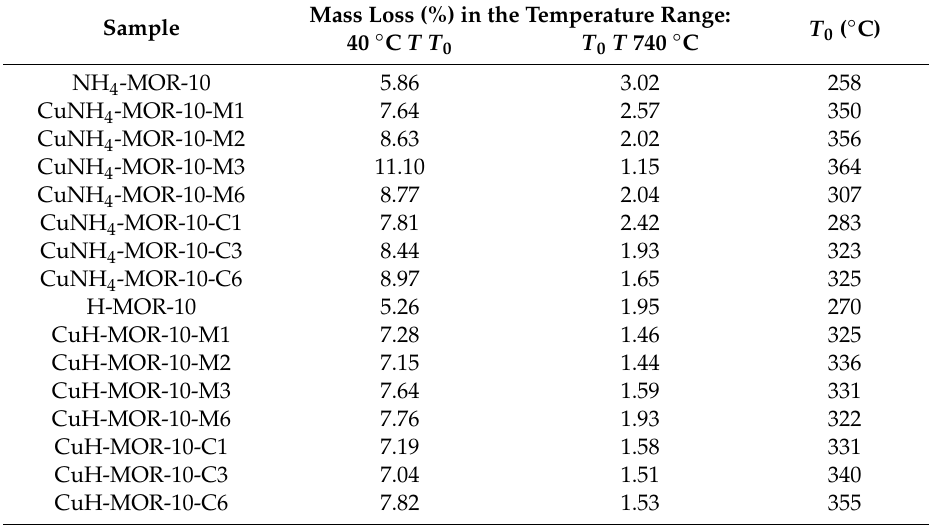
Table 3. Mass loss (%) due to water (and ammonia) release (below T 0 ) and due to dehydroxylation (above T 0